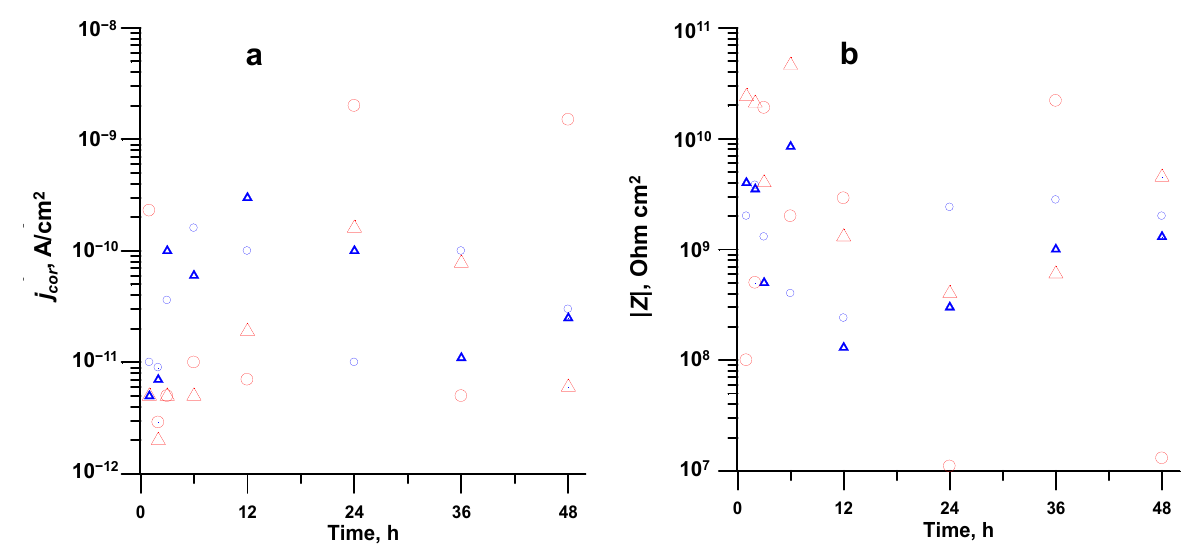
Figure 8. Change in corrosion current density ( a ) and low-frequency ( f = 0.05 Hz) impedance modulus ( b ) with different durations of immersion of superhydrophobic magnesium samples in P. aeruginosa dispersion in PBS. Blue and red symbols denote the values measured before and after immersion, respectively; for each time of immersion, the same symbols (triangles or circles) are related to the same sample.